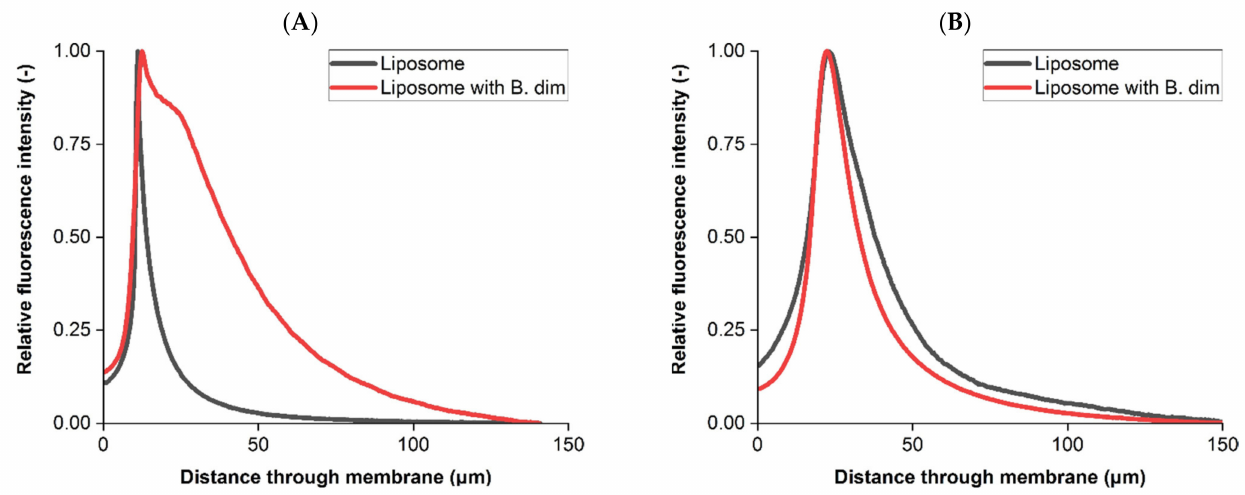
Figure 7. Intensity profiles of liposome retention when filtered with B. dim. ( A ) Upstream membrane profiles. ( B ) Down- stream membrane profiles. Intensity profiles presented are based on measurements from all 2D slices from a single sample imaged using CLSM. Filtration was performed at a constant differential pressure of 0.14